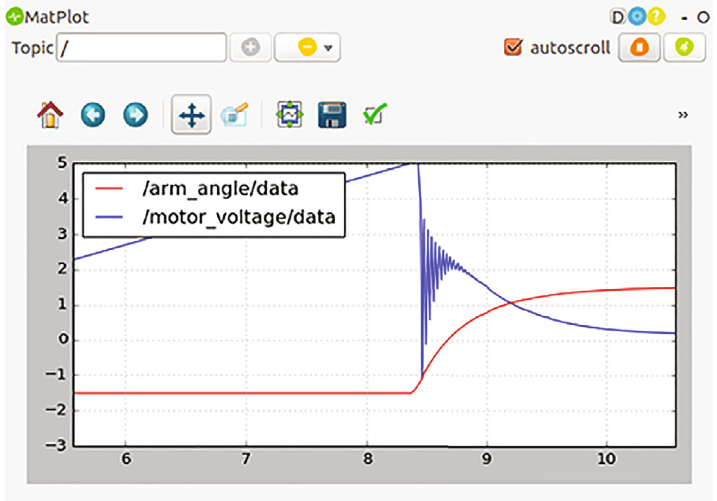
Figure 5: Graphs for position vs. time and motor vs. time obtained from a rqtplot tool when lifting a pendulum from resting